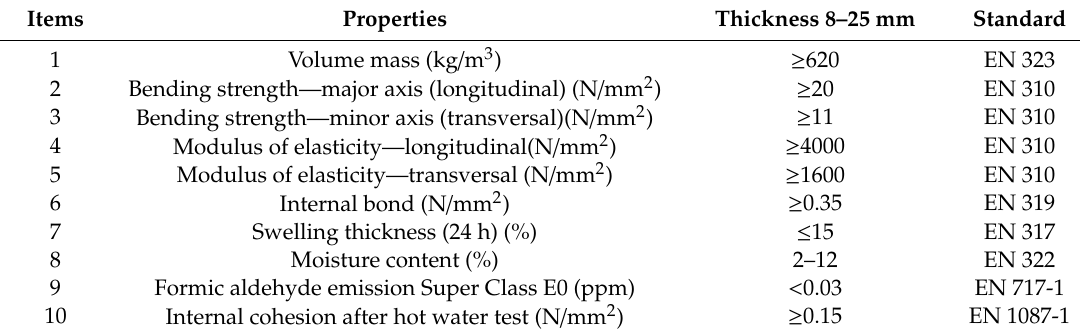
Table 1. Properties of boards with high-load-bearing capacity for the outside (OSB / 3–Krono)